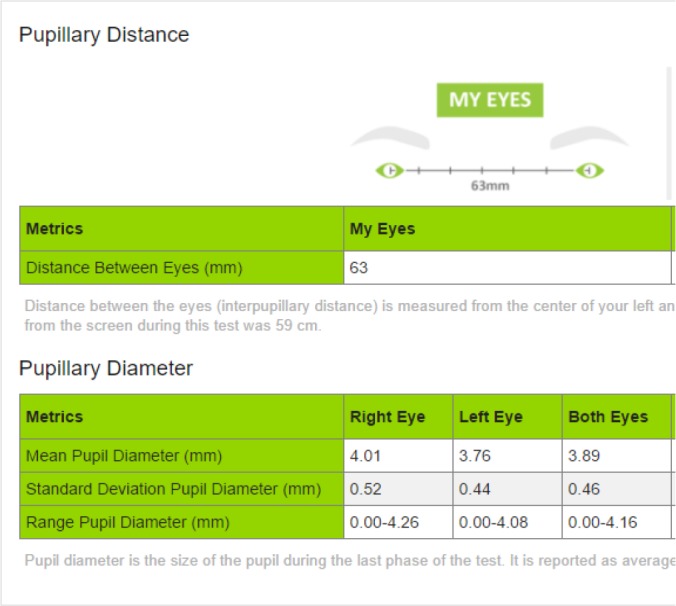
RightEye IPD/PD report.